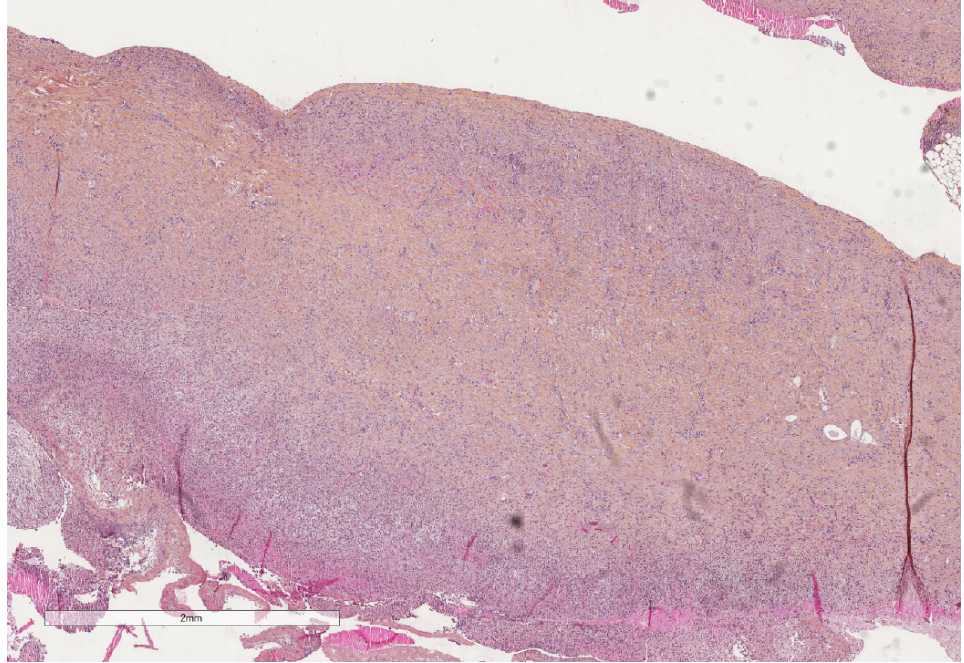
Figure 13. At this later stage, the pleura is severely thickened due to fibrosis (see next image for higher magnification). Hematoxylin, eosin, saffron staining ( × 20).